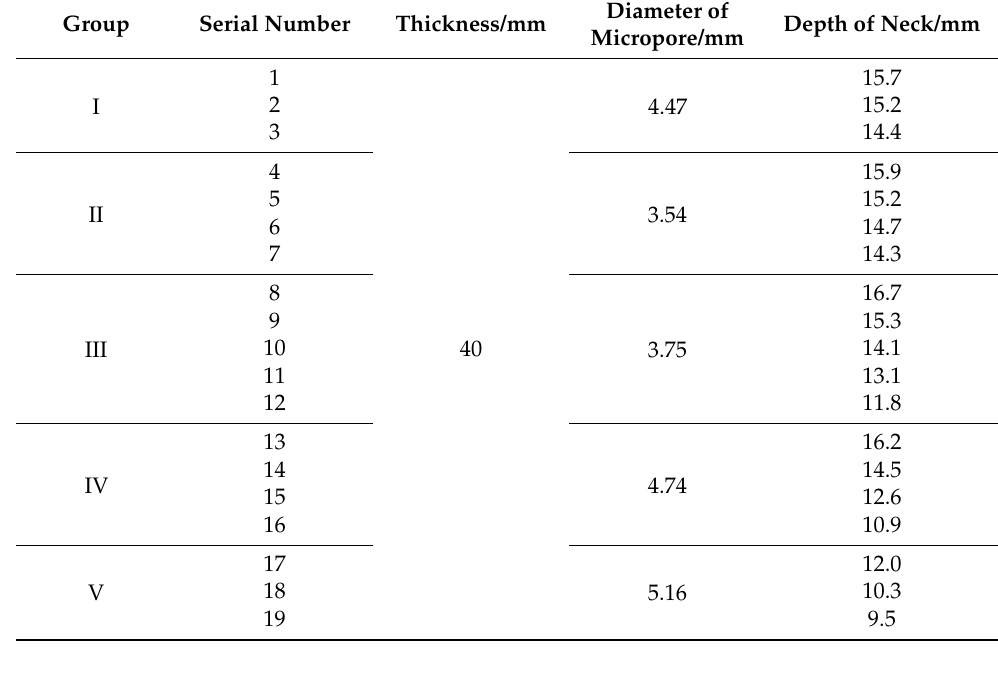
Table 2. The geometric parameters of the optimized acoustic metamaterial.